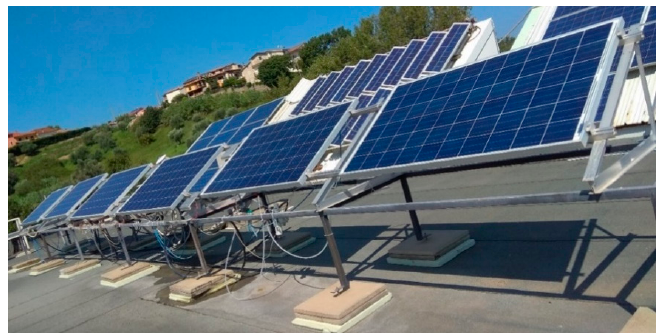
Figure 1. Experimental site overview.